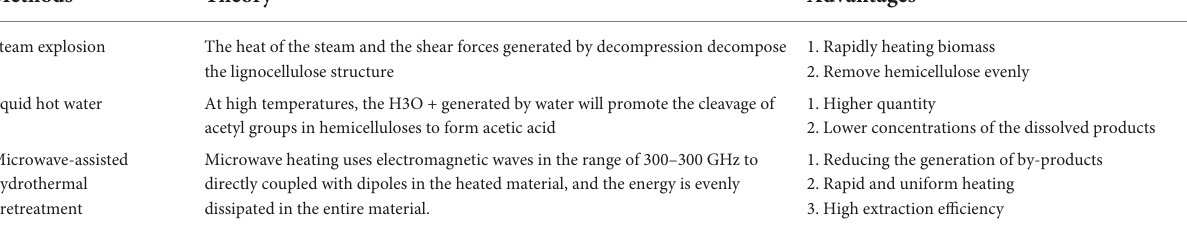
TABLE 2 Introduction of hydrothermal pretreatment